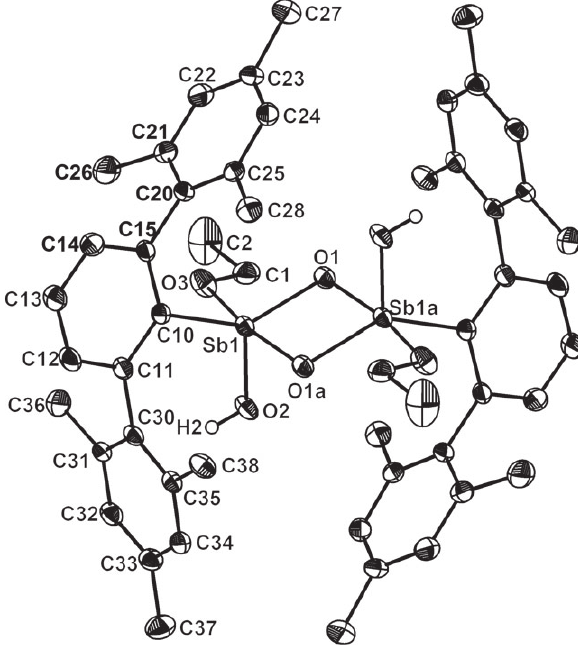
Table 1 Crystal data and structure refinement of [2,6-Mes